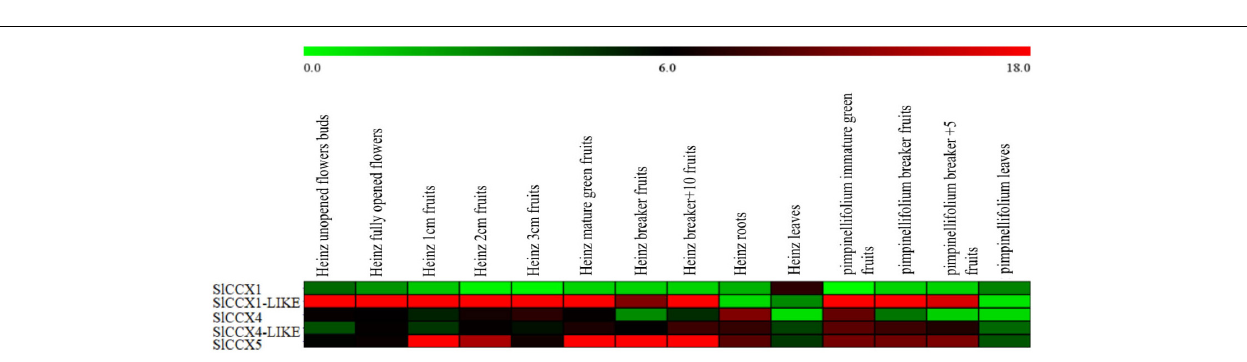
FIGURE 4 | Modeling structure of the Na + /Ca 2 + exchanger domains in SlCCXs. Note: (A–E) SlCCX1, SlCCX1-LIKE, SlCCX4, SlCCX4-LIKE, and SlCCX5.